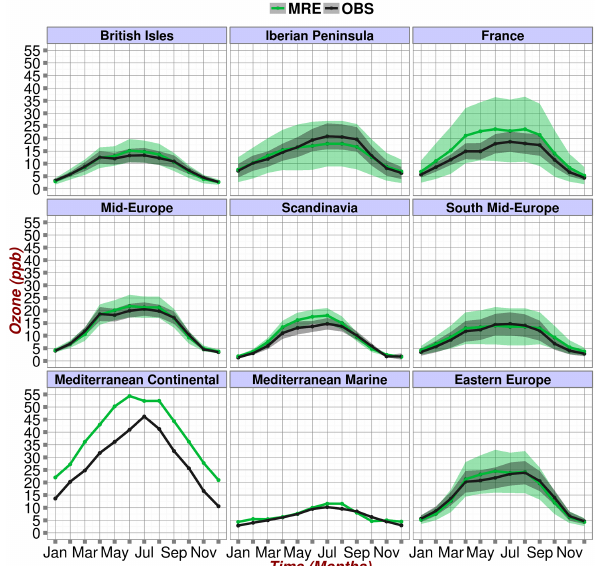
Figure 6. Annual cycle of the diurnal range of near-surface ozone for observations (black line) and MRE (green line) averaged over the time period 2003–2012 for the different European subregions. Shading areas denote the 95% confidence interval of the mean val- ues. The 95% confidence interval is not displayed for the Mediter- ranean subregions, which consist of a limited number of stations.